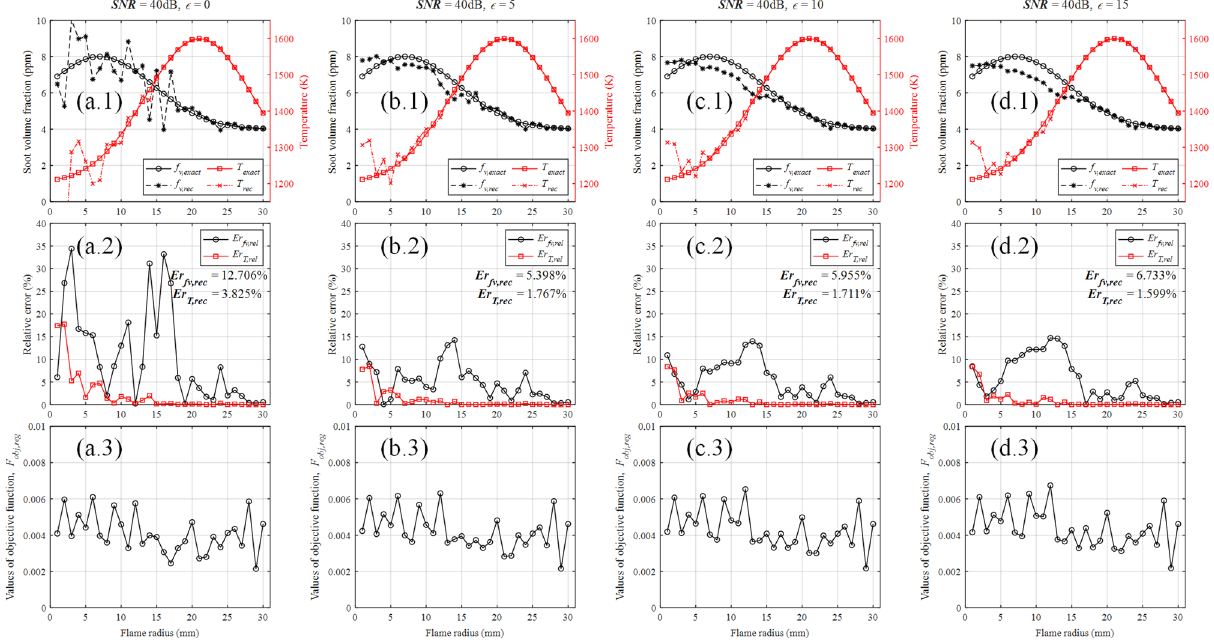
Figure 13. The reconstructed results of different regularization parameters with SNR of 40 dB. ( a ) ε = 0. ( b ) ε = 5. ( c ) ε = 10. ( d ) ε =